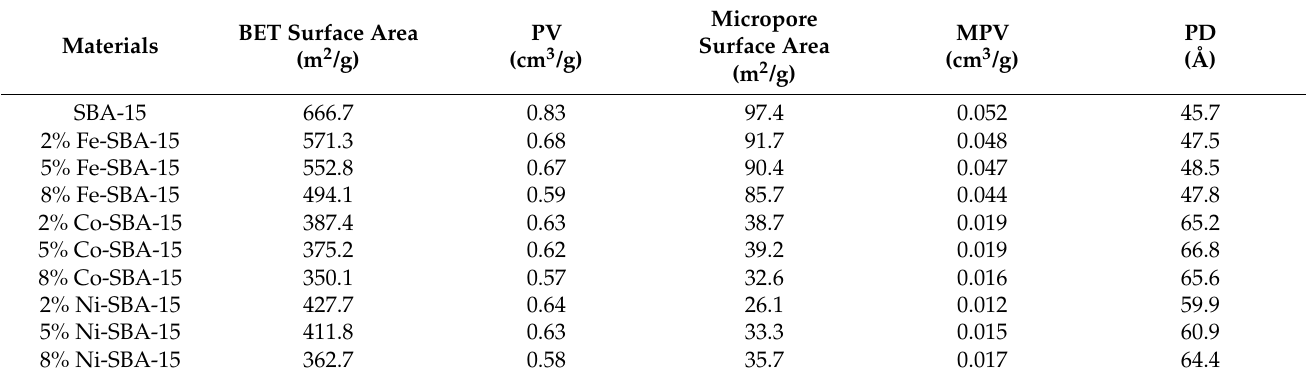
Table 1. Pore characteristics of SBA-15 and Fe-, Co-, and Ni-impregnated (2–8 wt%)